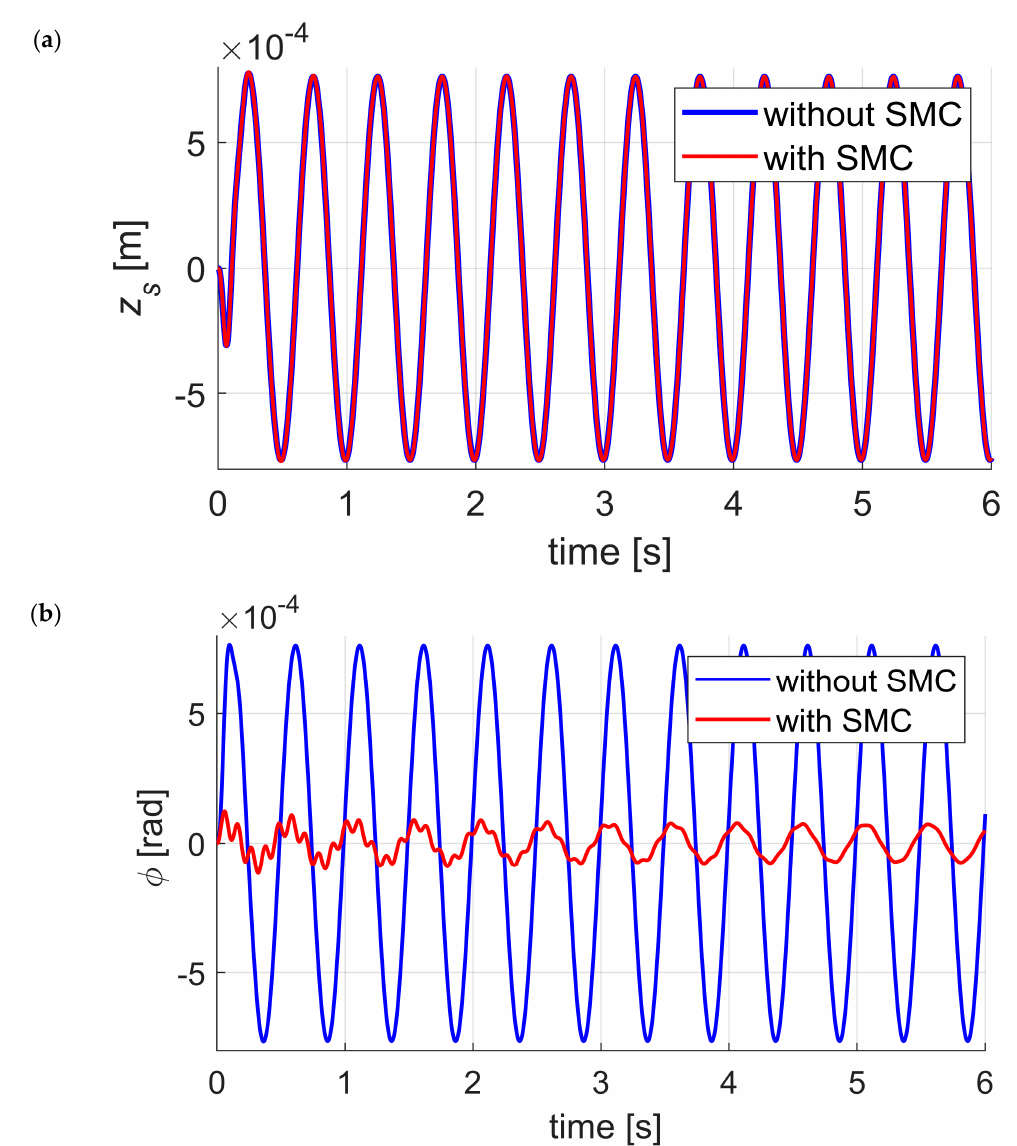
Figure 4. Time courses of the: vertical displacement z s ( a ), and roll angle ϕ ( b ) for A w _ jR = A w _ jL = 0.01 m, f w _ jR = f w _ jL = 2